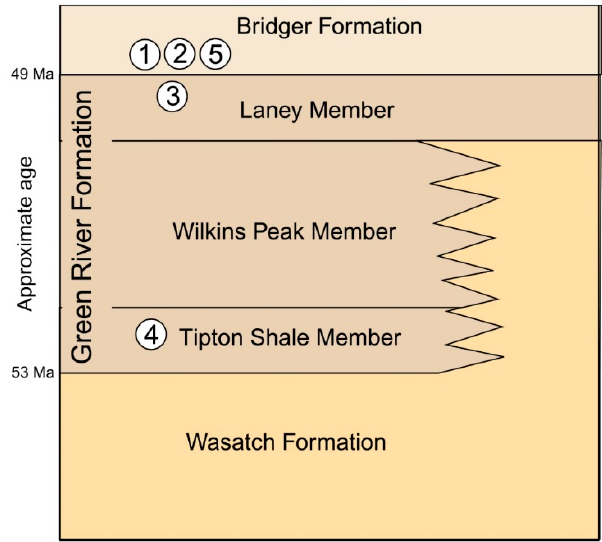
Figure 3. Generalized stratigraphy of the Eocene sediments in the Green River basin, showing the relative position of the fossil wood localities. (1) Big Sandy Reservoir; (2) Oregon Buttes; (3) Blue Forest; (4) Parnell Draw; (5) Hay’s Ranch. This diagram is a simplification; stratigraphic members typically have interfingering contacts.